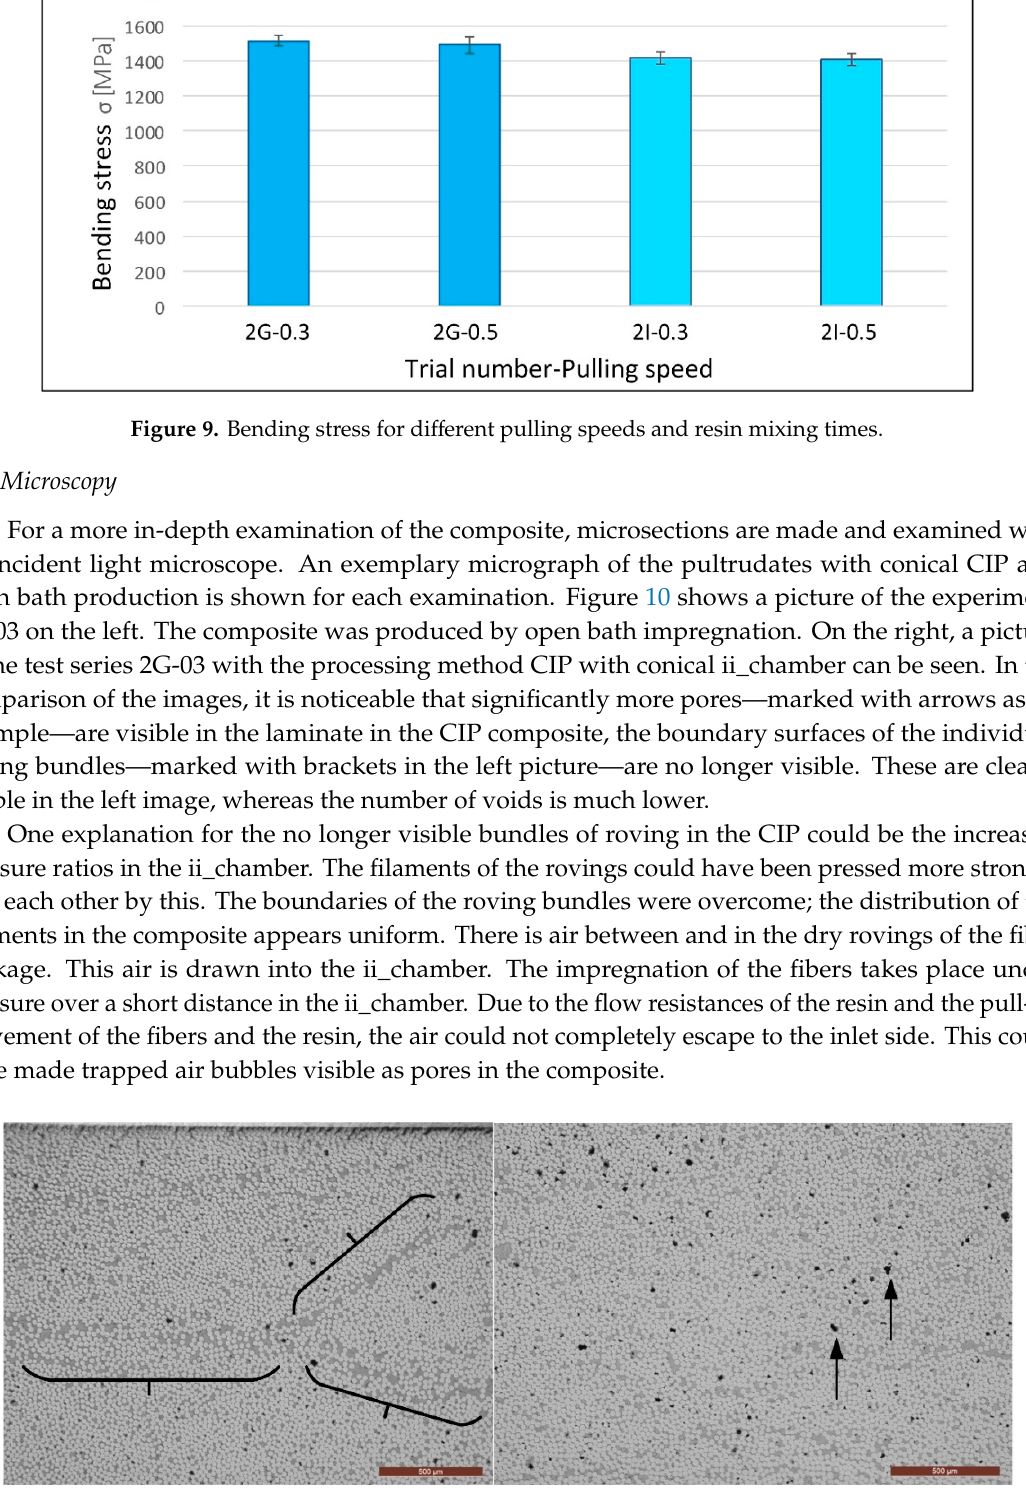
Figure 10. Microsections of open bath ( left ) und conical ii_chamber ( right ) composites .